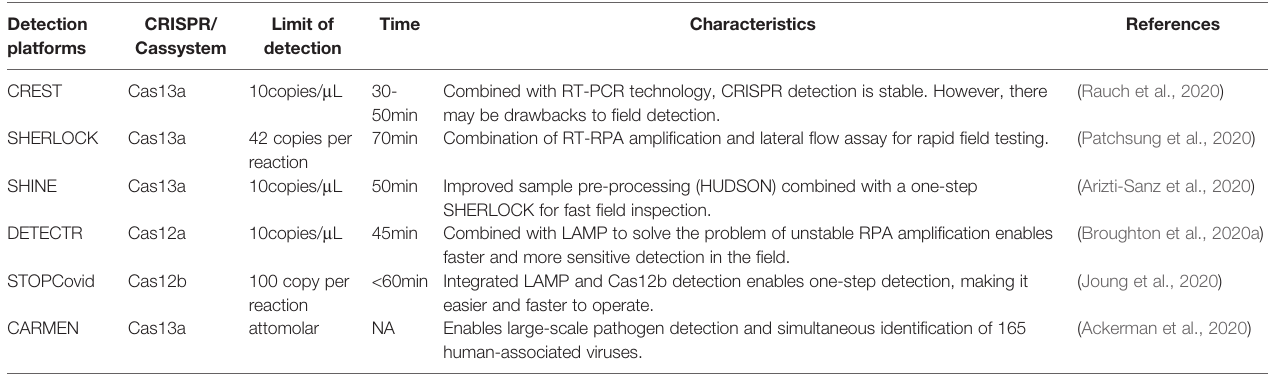
TABLE 2 | Summary of the CRISPR/Cas platform for SARS-CoV-2 detection. Detection